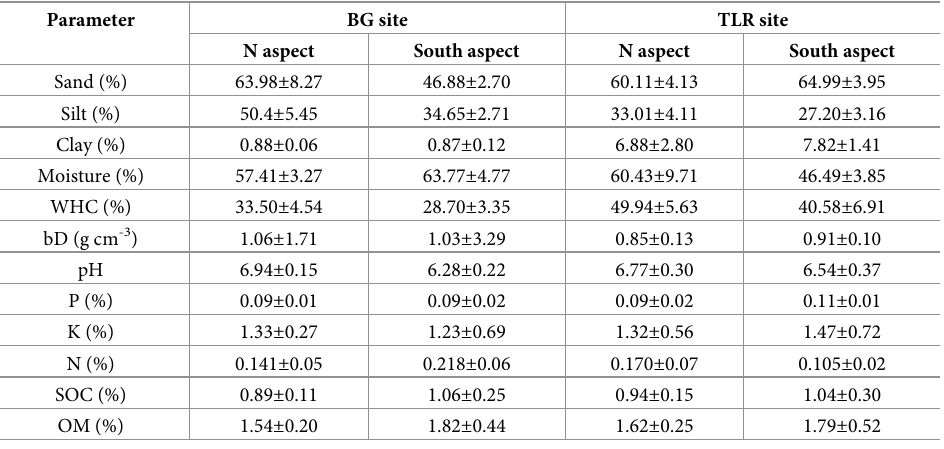
In the context of frequency, the occurrence of individuals in the seedling, sapling, and tree stages on the southern aspect was highly correlated with individuals in the seedling, sapling and tree stages on the northern aspect of both sites within the Reserve (significant at p � 0.05) (Tables 7 and 8). This analysis provides a clearer picture of the complex interrelationships among the different vegetation layers. Relationship between species richness and species diversity The t-test value for tree and herbaceous species density along the altitudinal gradient showed significant variation (p < 0.05). However, there were no significant differences in shrub species along the altitudinal gradient (P < 0.05). On the other hand, the correlation between Table 6. Physiochemical properties of soil in TLR and BG sites.